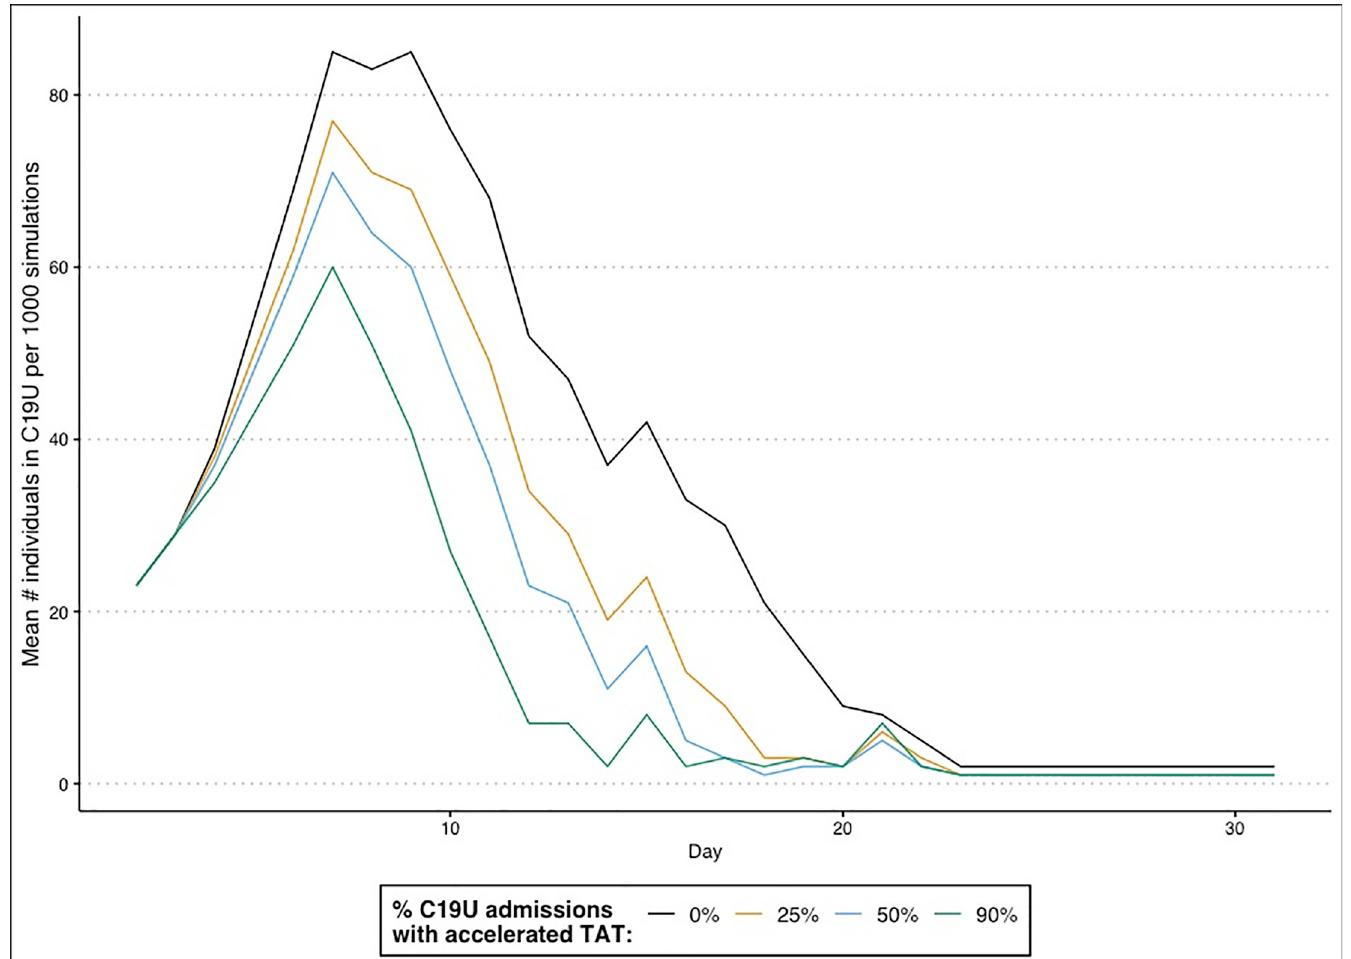
Fig 2. The mean daily occupancy of the C19U when an accelerated TAT was available for 0% (black), 25% (yellow), 50% (blue), or 90% (green) of admissions tested.